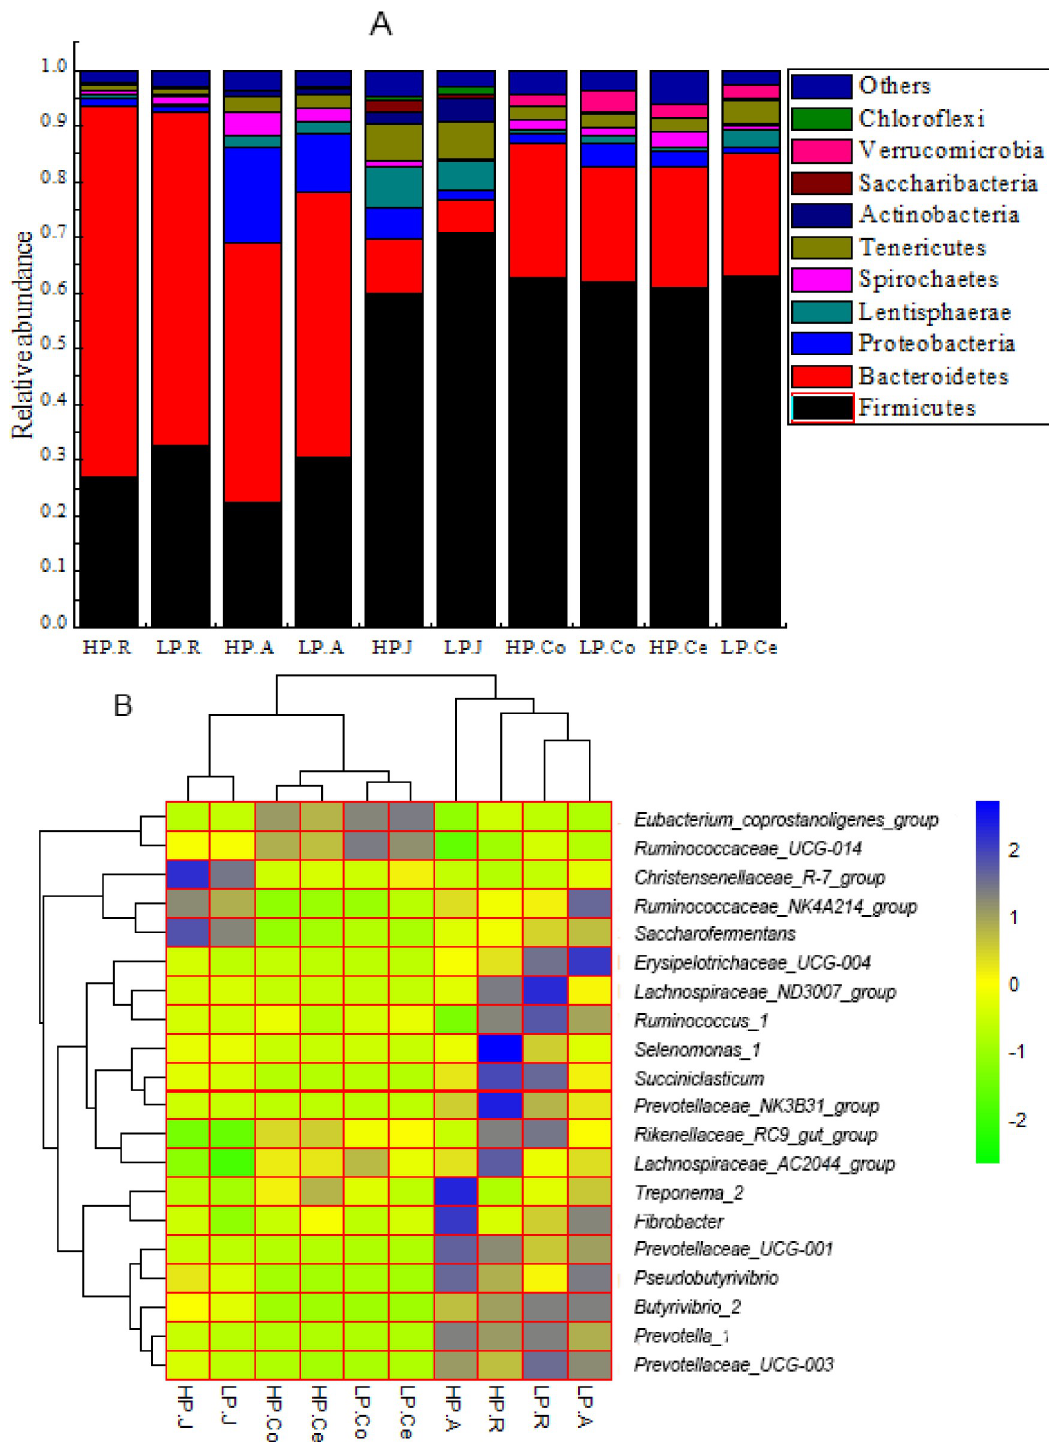
Fig 3. A: Bacterial compositions across the gastrointestinal tract at the phylum level (only the top 10 abundant phyla are presented). HP.R: rumen of HP; LP.R: rumen of LP; HP.A: abomasum of HP; LP.A: abomasum of LP; HP.J: jejunum of HP; LP.J: jejunum of LP; HP.Co: colon of HP; LP.Co: colon of LP; HP.Ce: cecum of HP; LP.Ce: cecum of LP. B: Heatmap of the core genera across the gastrointestinal tract (the relative abundance of microbes was log-transformed, and only the top 20 abundant genera are presented). The closer to the color blue, the higher the relative abundance, while the closer to the color green, the lower the relative abundance.